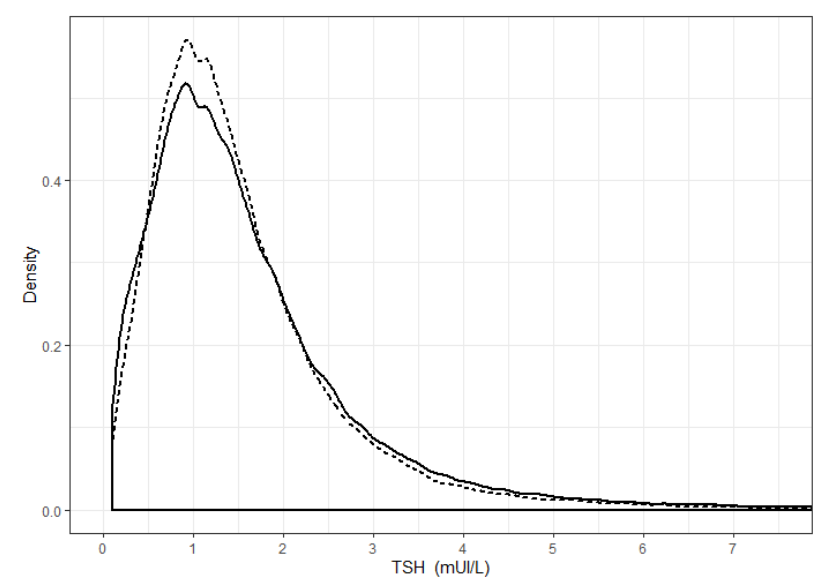
Figure 3. Thyrotropin (TSH) distribution, according to sex. Continuous line: data obtained from females; dotted line: data obtained from males .